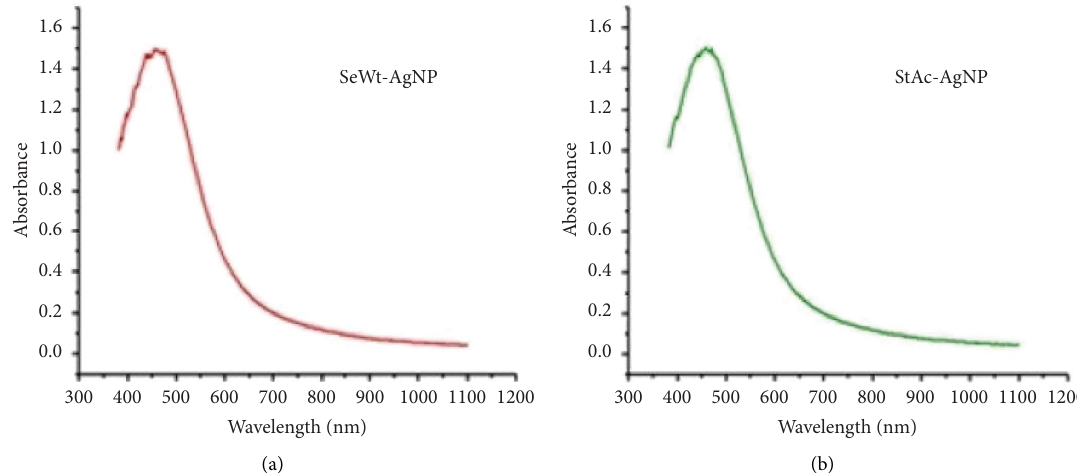
Figure 2: UV-visible spectroscopy graph for (a) AgNPs synthesized from seed extracts of W. tinctoria and (b) AgNPs synthesized from stem extracts of A. catechu .